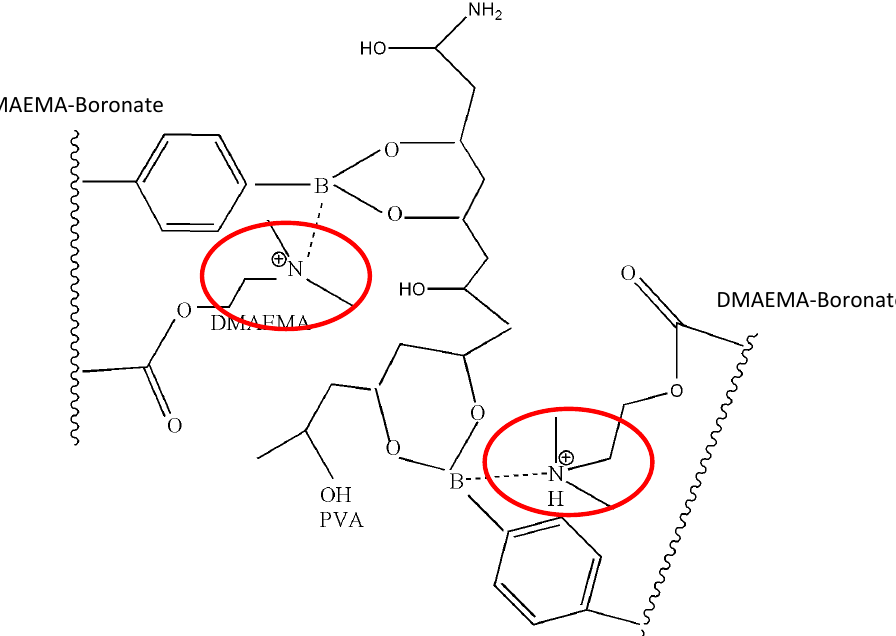
Figure 1. Schematic representation of stabilization of boronate by tertiary amine of dimethyl aminoethyl methacrylate (DMAEMA) in a submicron particle (SMP) system. The pKa of boronate was reduced by the addition of amino group in the vicinity of boronic acid by the formation of a coordination bond between nitrogen and boron.